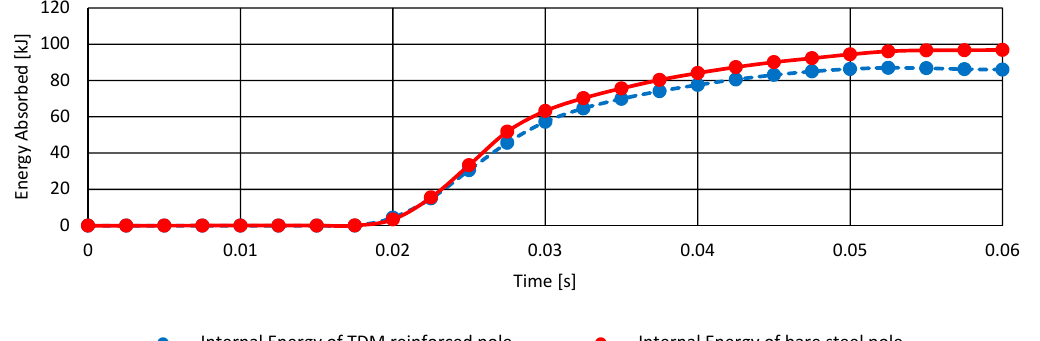
Figure 10. Impact energies were absorbed by the street pole (one as a bare street pole and the other shielded by TDM material of 35 mm) when collided by the vehicle through a frontal collision scenario at speeds of 12 ms − 1 , 17 ms − 1 and 22 ms − 1 .